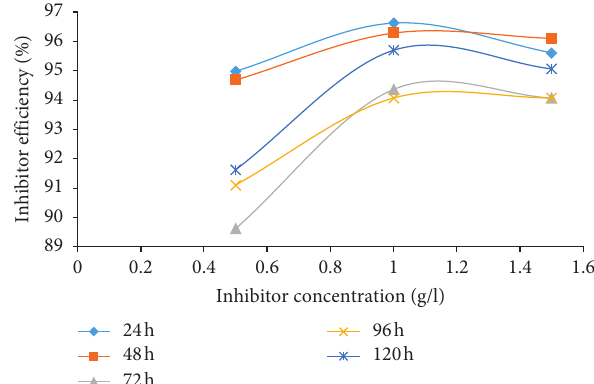
Figure 4: Inhibitor efficiency (%) versus concentration of MBZ for mild steel in 1.5 M H 2 SO 4